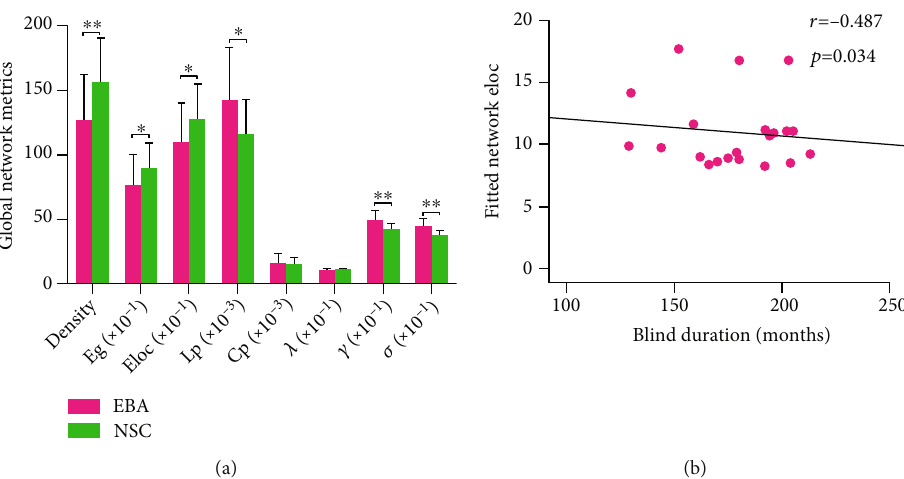
Figure 1: Group di ff erences in global network metrics of WM structural networks (a) and the correlation between network Eloc and blind duration in the EBA cohort (b). (a) Bar charts and error bars represent the mean values and standard deviations, respectively (EBA: n =21; NSC: n =22). ∗ p < 0 : 05 (Bonferroni corrected); ∗∗ p < 0 : 001 (Bonferroni corrected). (b) Scatterplots show the signi fi cantly negative correlation between network Eloc and blind duration in the EBA cohort ( n =21). The fi tted values indicate the residuals of original values of Eloc adjusted age and sex and corrected with mean value. Abbreviations: Eg: global e ffi ciency; Eloc: local e ffi ciency; Lp: shortest path length; Cp: clustering coe ffi cient; λ : normalized path length; γ : normalized clustering coe ffi cient; σ : small-world parameters; EBA: early-blind adolescents; NSC: normal-sighted controls. Table 4: Brain regions with signi fi cant nodal di ff erences between